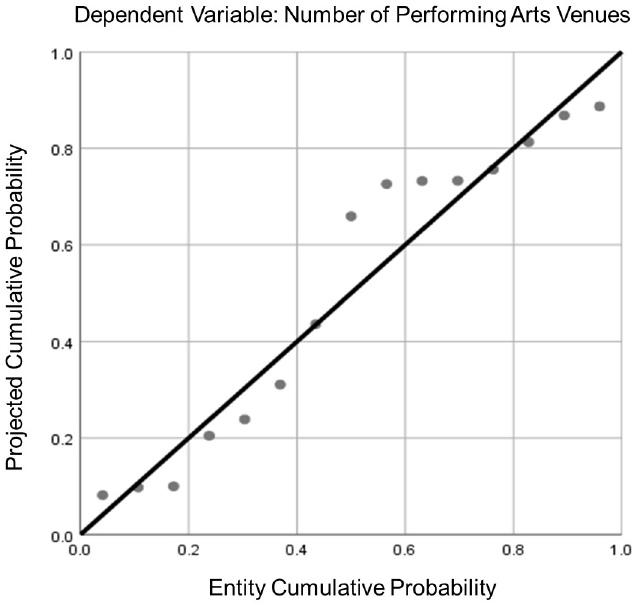
Fig 4. Normal P-P plots of regression standardized